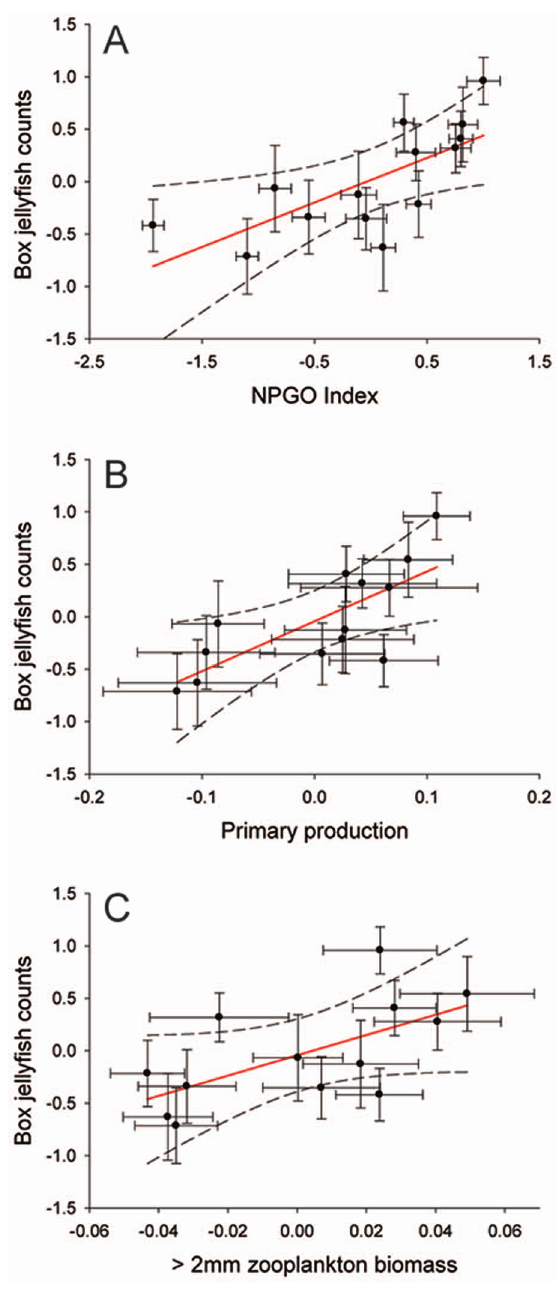
Figure 5. Significant relationships among box jellyfish abun- dance at Waikiki Beach and environmental variables. A: North Pacific Gyre Oscillation (NPGO), B: Primary production, C: zooplankton biomass within the sub-tropical North Pacific. Significant linear relationships were detected using General Regression Models ( GRM ). Biogeochemical variables were obtained at Station ALOHA, from the Hawaiian Oceanographic Time-series program (HOT) at http://hahana. soest.hawaii.edu/hot/. Solid red line represents the model fit, and dashed lines represent 99% confidence levels. Bars represent standard errors.